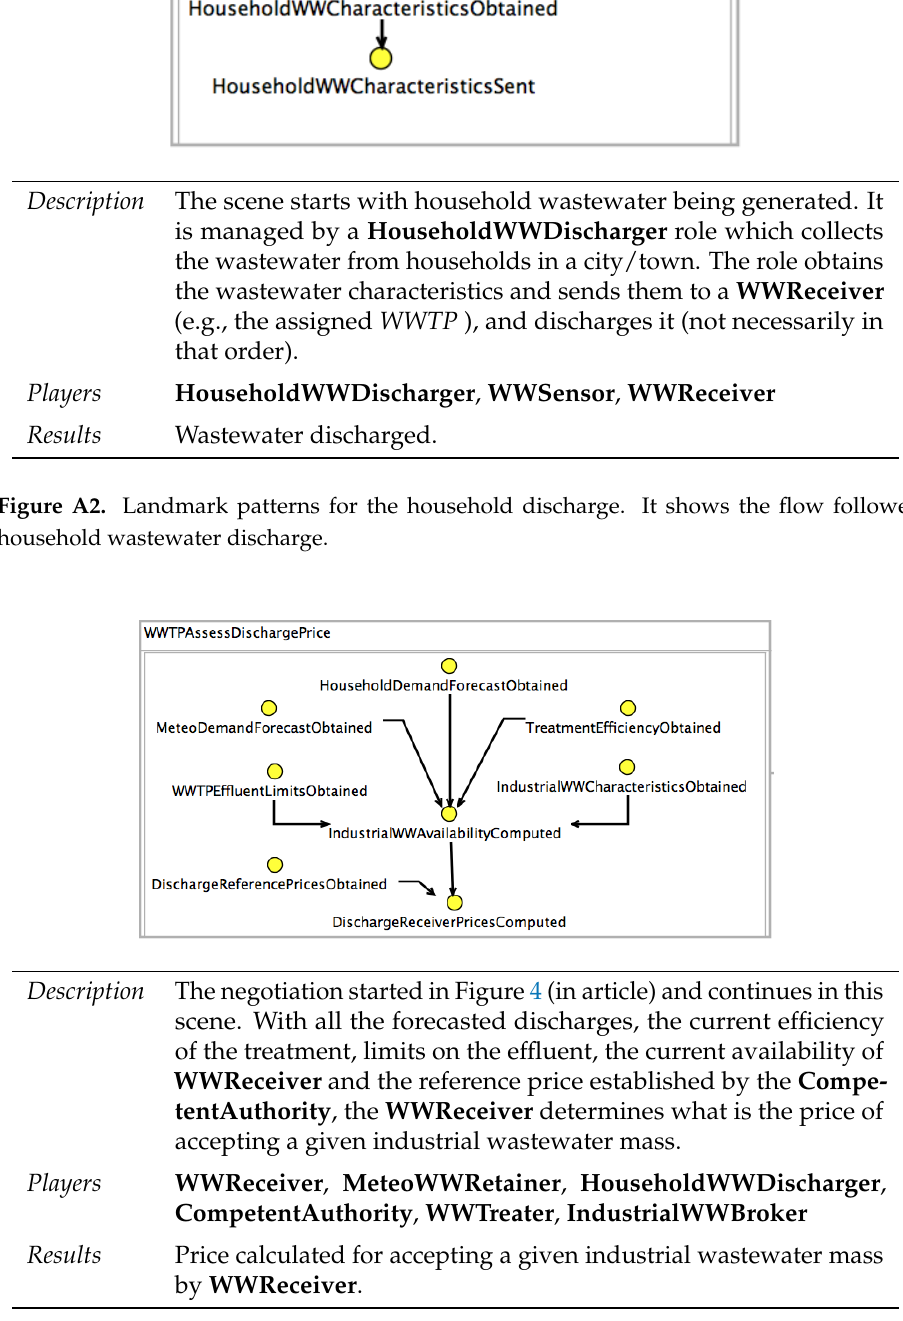
Figure A3. Landmark patterns for the industry price negotiation. This shows how the price to handle an industrial discharge is determined according to household and meteorological demand forecasts, limitations imposed by norms, volume availability and the wastewater